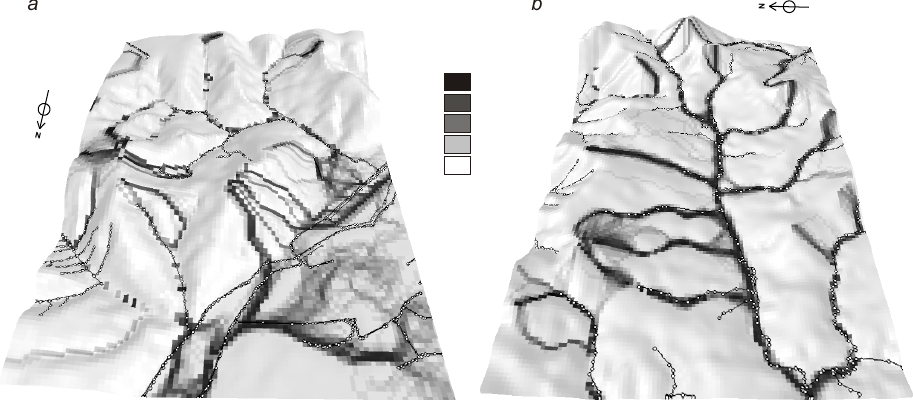
Fig. 6. Propagated error of mapping streams estimated using Eq. (5); visualized in SAGA GIS: (a) Baranja hill case study; (b) Zlatibor case study. The lines indicate the true streams – digitized from topo